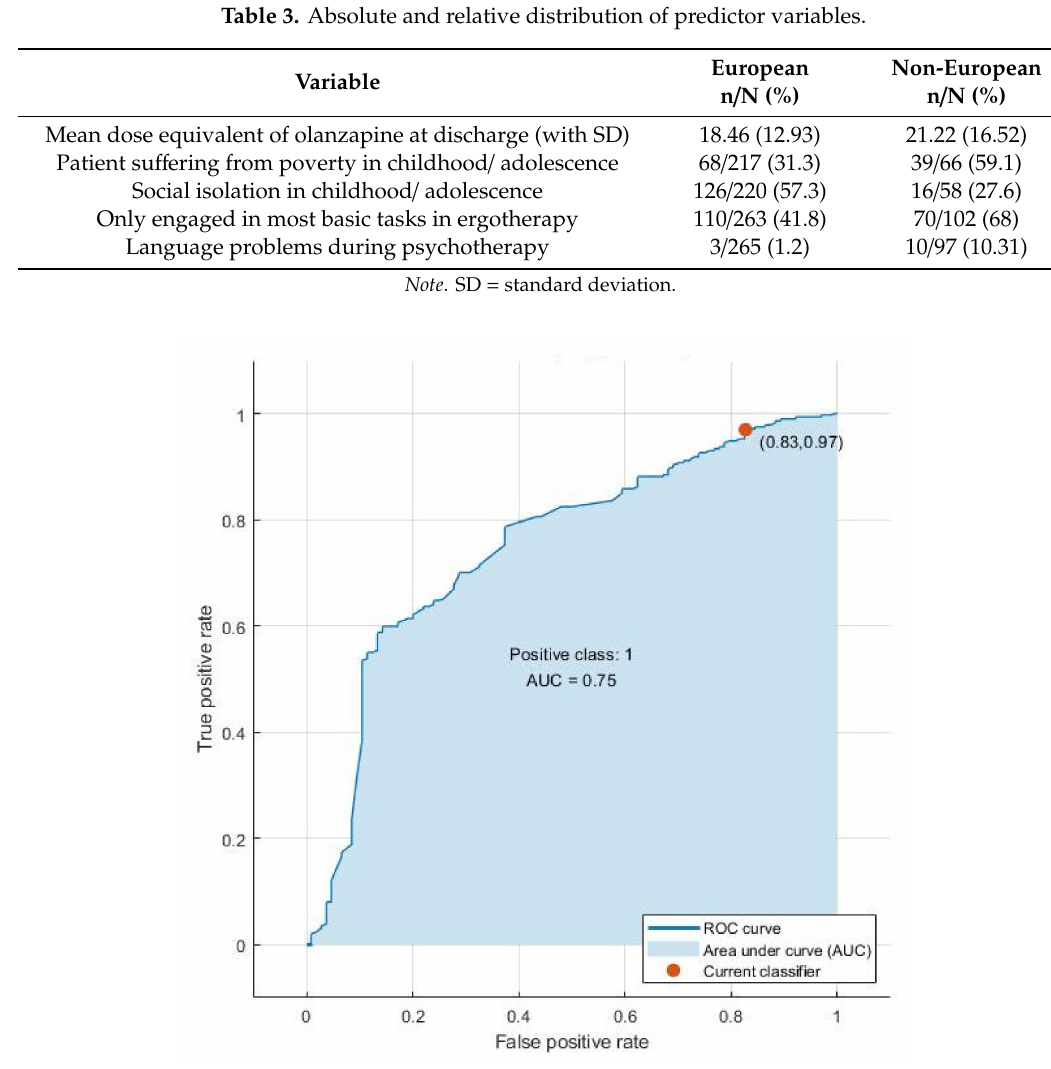
Figure 2. Receiver operating characteristic (ROC) curve of the final selected model (tree algorithm). Table 4. Final tree model performance